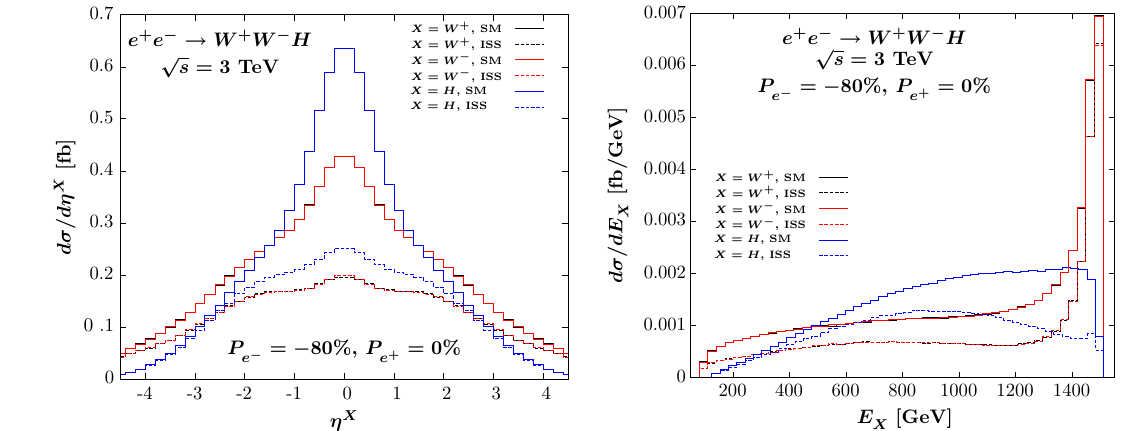
Fig. 4 Pseudo-rapidity (left) and energy (right) distributions of the W + (black), W − (red) and Higgs (blue) bosons in the process e + e − → W + W − H at a c.m. energy of 3 TeV, using a − 80% polarised electron